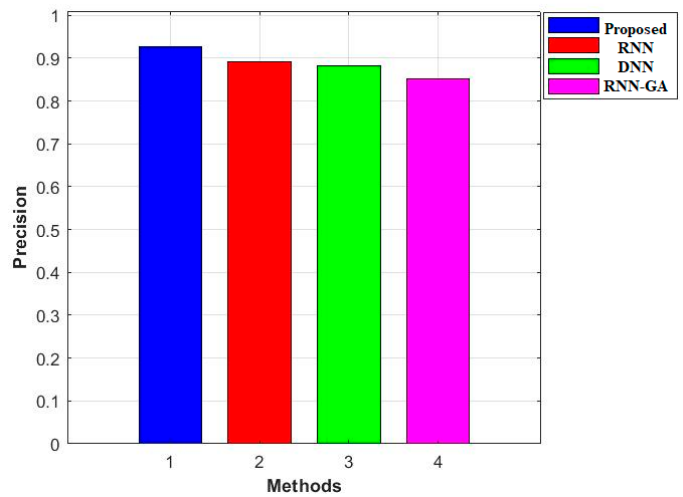
Figure 10. Precision performance of confusion matrix. Table 3. Performance metrics comparison.